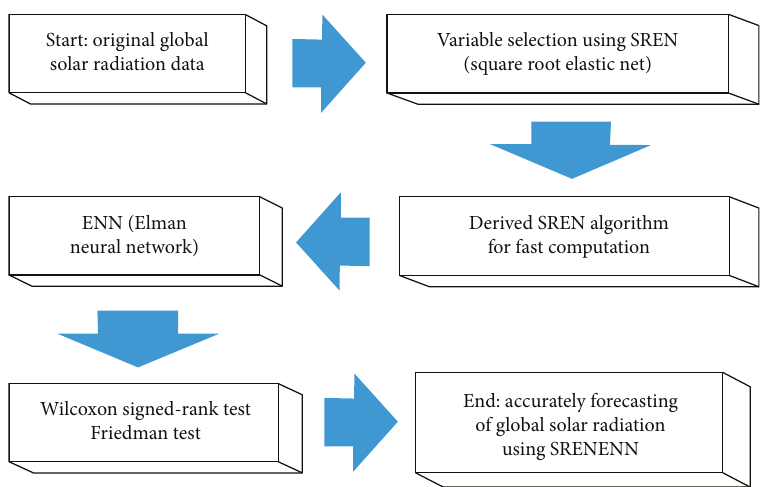
Figure 1: A schematic overview of the whole